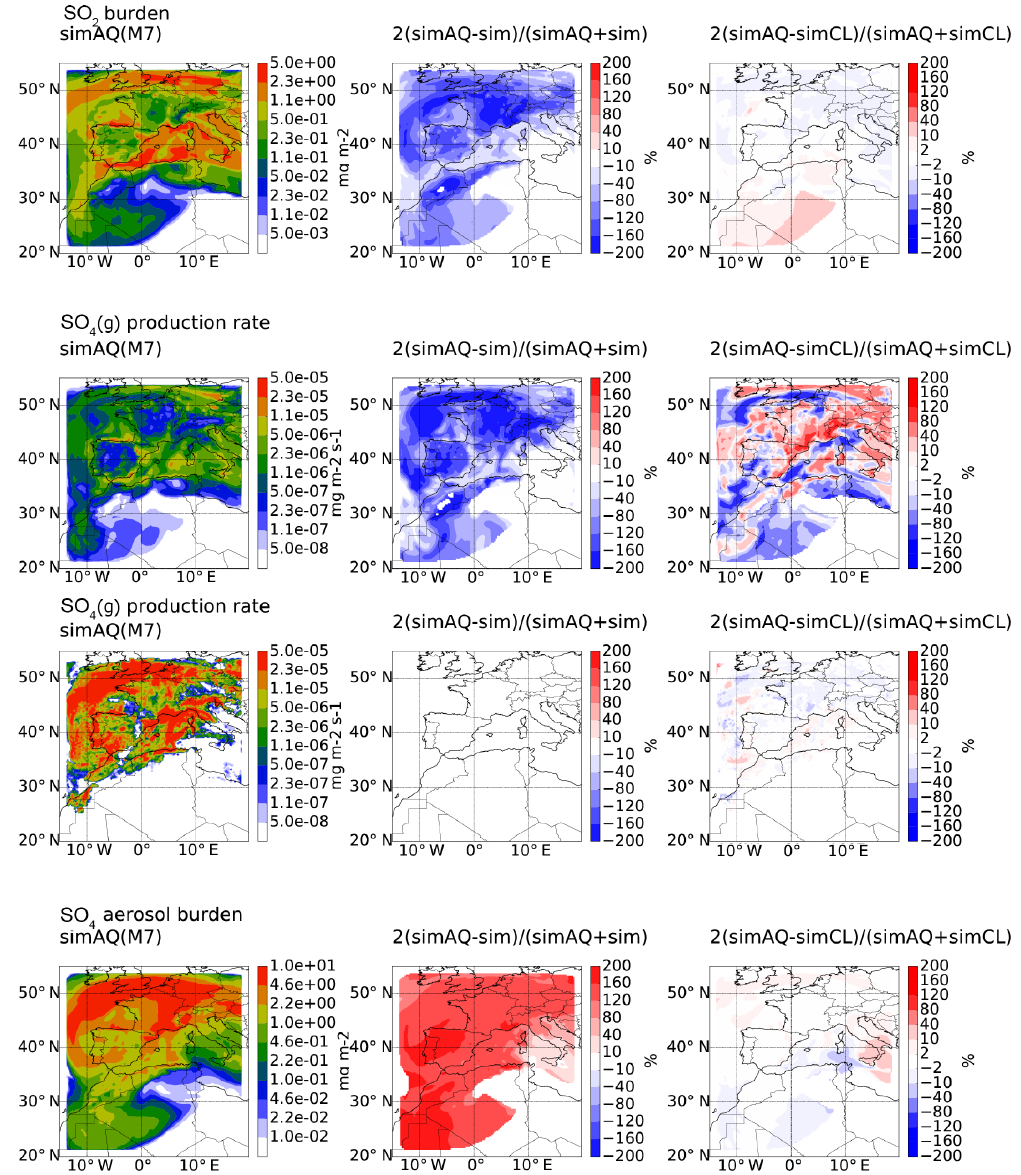
Figure 6. Sulfate production from aqueous-phase chemistry and using climatological oxidant fields. The figure compares the simAQ sim- ulation (left columns) to sim (percentage-difference plots in the middle column) and simCL simulations (percentage-difference plots in the right column; note the different color scales). The first and fourth rows show the burden of SO 2 and sulfate aerosol. The second and third rows depict vertical integrals of gas- and aqueous-phase production rates of SO 4 . See Fig. 3 for plot